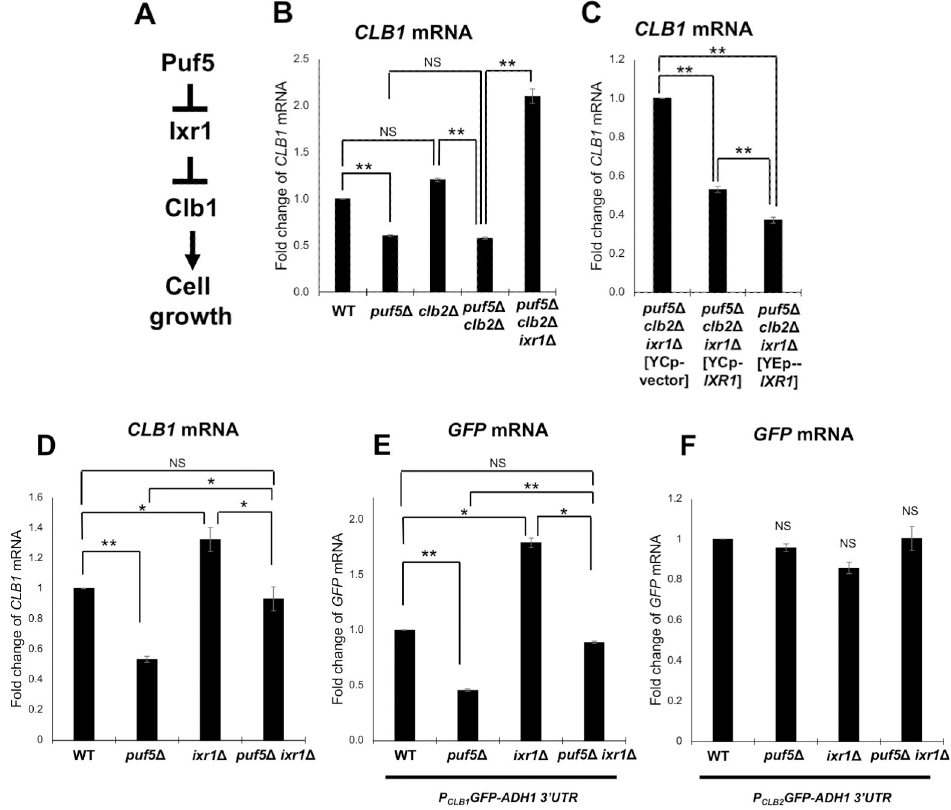
Fig 6. Ixr1 is a downstream factor of Puf5 and negatively regulates CLB1 expression. (A) A model showing how Puf5 functions in cell growth through the CLB1 regulation mediated by Ixr1. The hypothesis is presented that Puf5 negatively regulates the expression of the Ixr1 repressor, and Ixr1negatively regulates the CLB1 transcription. (B)The CLB1 mRNA levels in wild-type, the puf5 Δ mutant, the clb2 Δ mutant, the puf5 Δ clb2 Δ double mutant, and the puf5 Δ clb2 Δ ixr1 Δ triple mutant. The cells were cultured in a YPD medium containing 10% sorbitol at 28˚C until the exponential phase. The CLB1 mRNA levels were quantified by qRT-PCR analysis, and the relative mRNA levels were calculated using the SCR1 reference gene. The data shows the mean ± SE (n = 5) of the fold change of CLB1 mRNA relative to the mRNA level in wild-type. � P < 0.05, �� P < 0.01 as determined by Tukey’s test. (C) The CLB1 mRNA levels in the puf5 Δ clb2 Δ ixr1 Δ mutant harboring plasmids YCplac33, YCplac33- IXR1 , or YEplac195- IXR1 . The strains were cultured in an SC-Ura medium at 25˚C until the exponential phase. The CLB1 mRNA levels were quantified by qRT-PCR analysis, and the relative mRNA levels were calculated using the SCR1 reference gene. The data shows the mean ± SE (n = 5) of the fold change of CLB1 mRNA relative to the mRNA level in the strain harboring the YCplac33 plasmid. � P < 0.05, �� P < 0.01 as determined by Tukey’s test. (D) The CLB1 mRNA levels in wild-type, the puf5 Δ mutant, the ixr1 Δ mutant, and the puf5 Δ ixr1 Δ double mutant. The cells were cultured in a YPD medium at 28˚C until the exponential phase. The CLB1 mRNA levels were quantified by qRT-PCR analysis, and the relative mRNA levels were calculated using the SCR1 reference gene. The data shows the mean ± SE (n = 5) of the fold change of CLB1 mRNA relative to the mRNA level in wild-type. � P < 0.05, �� P < 0.01 as determined by Tukey’s test. (E, F) The GFP mRNA levels in wild-type, the puf5 Δ mutant, the ixr1 Δ mutant, and the puf5 Δ ixr1 Δ double mutant. The strains harboring the YCplac33- CLB1 promoter- GFP - ADH1 3´ UTR plasmid (E) or YCplac33- CLB2 promoter- GFP - ADH1 3´ UTR plasmid (F) were cultured in an SC-Ura medium at 28˚C until the exponential phase. The GFP mRNA levels were quantified by qRT-PCR analysis, and the relative mRNA levels were calculated using the SCR1 reference gene. The data shows the mean ± SE (n = 3) of the fold change of GFP mRNA relative to the mRNA level in wild-type. � P < 0.05, �� P < 0.01 as determined by Tukey’s test. puf5 Δ ixr1 Δ double mutant, the puf5 Δ mutation decreased the endogenous CLB1 and GFP mRNA levels even in the absence of Ixr1 (Fig 6D and 6E). These results imply that Puf5 regu- lates CLB1 expression in both Ixr1-dependent and -independent manners. Since the above data suggested that Ixr1 negatively regulates CLB1 transcription, we ques- tioned whether this regulation results from the direct binding of Ixr1 to the CLB1 promoter.